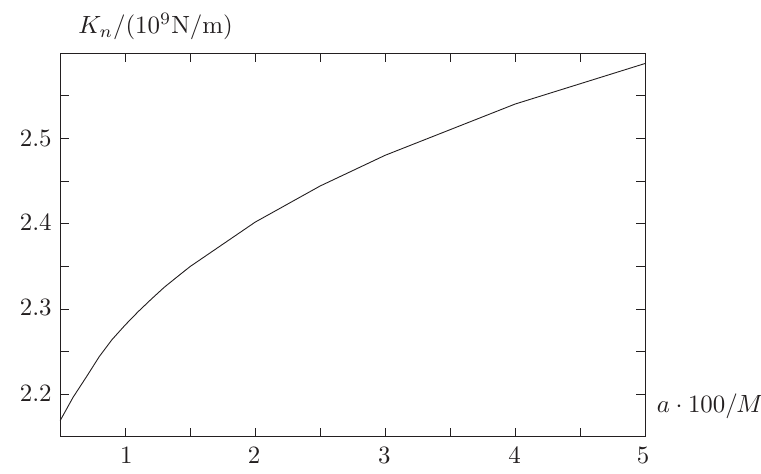
Figure 10: Helical tooth stiffness as a function of contact zone half-width.